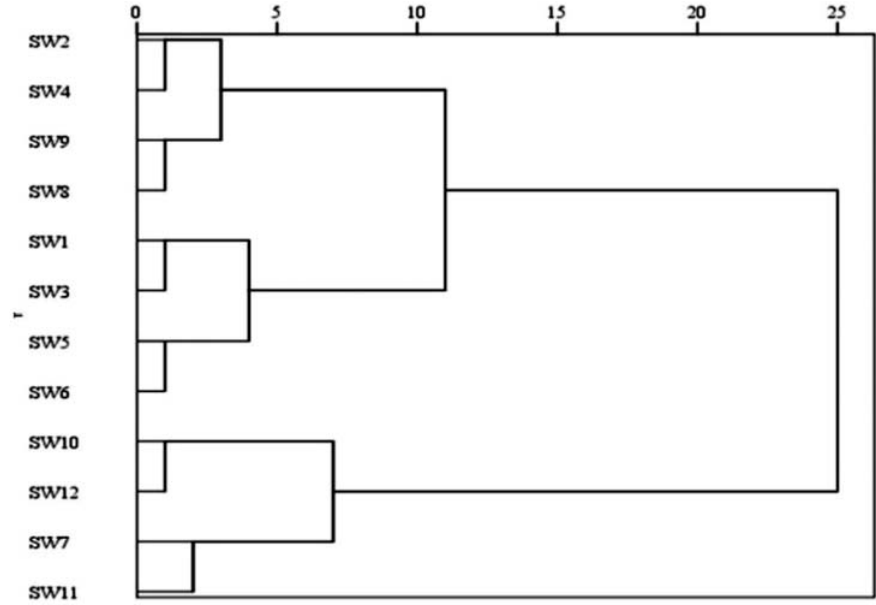
Figure 4. Dendrogram constructed with minimum linkage method for twelve Slovenian red